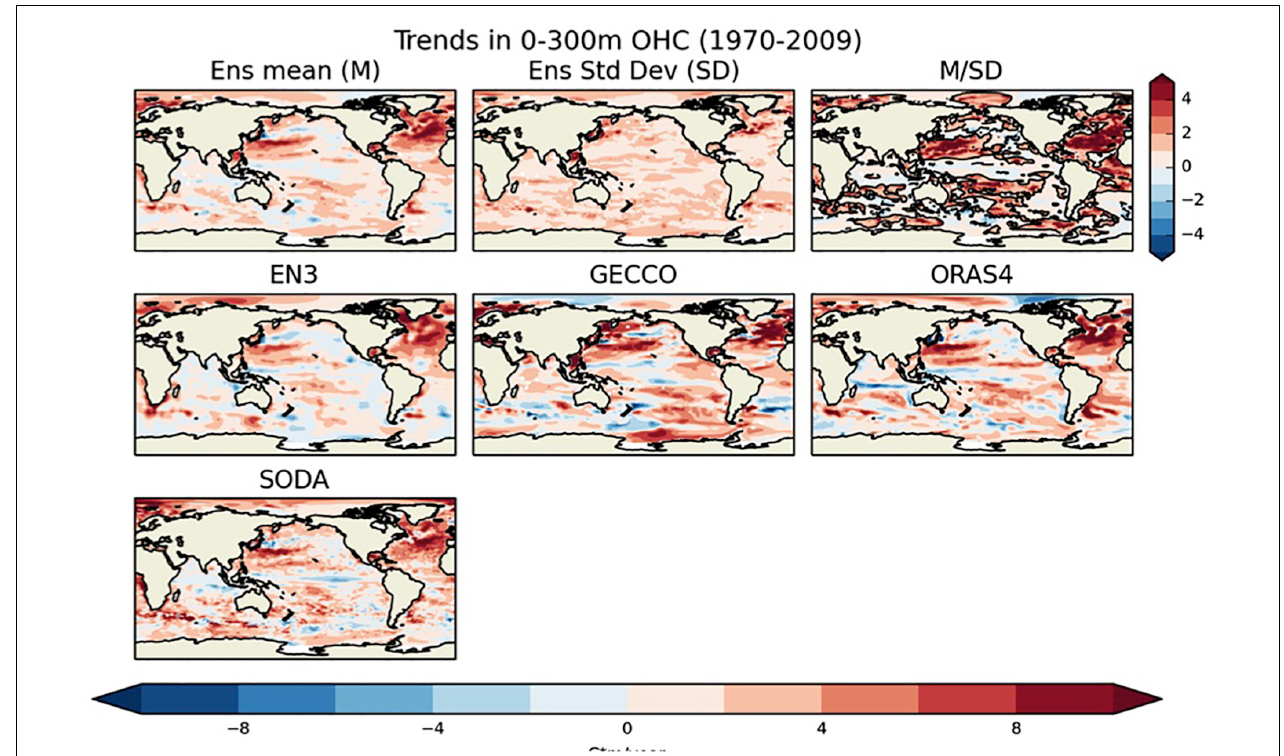
FIGURE 10 | Trends in 0–300 m vertically integrated temperature (Celsius meters per year) for the period 1970–2009. White areas indicate where no data are available. Also shown is the ensemble mean trend (M), the standard deviation of ensemble trends (SD), and the ratio of the two (M/SD). The ensemble values ( top row ) are computed for each grid box based on all available data (from Palmer et al.,